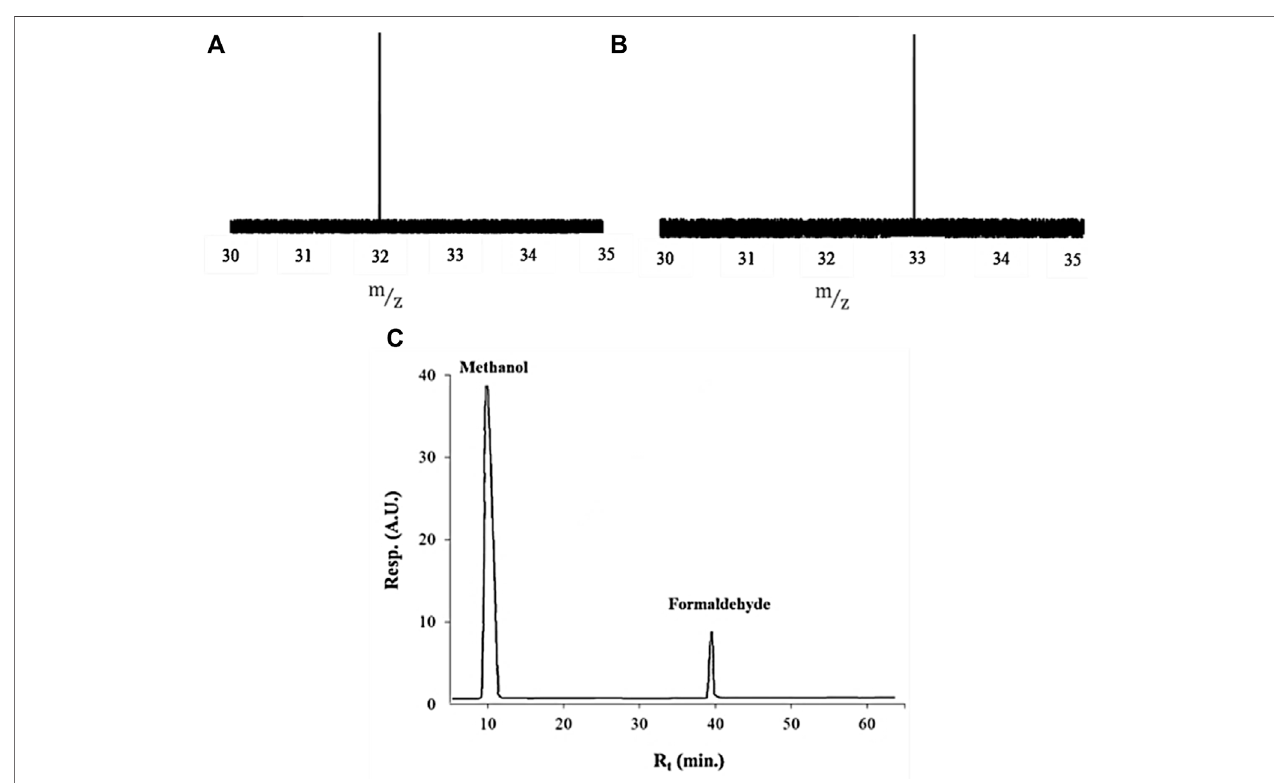
FIGURE 4 | Identi fi cation of generated products in acetate solution prepared in both solvents. (A) GC-MS spectra of D 2 CO between 30 – 35 (m/z), (B) GC-MS spectra of CH 3 OD between 30 – 35 (m/z), and (C) HPLC chromatogram of formaldehyde and methanol.